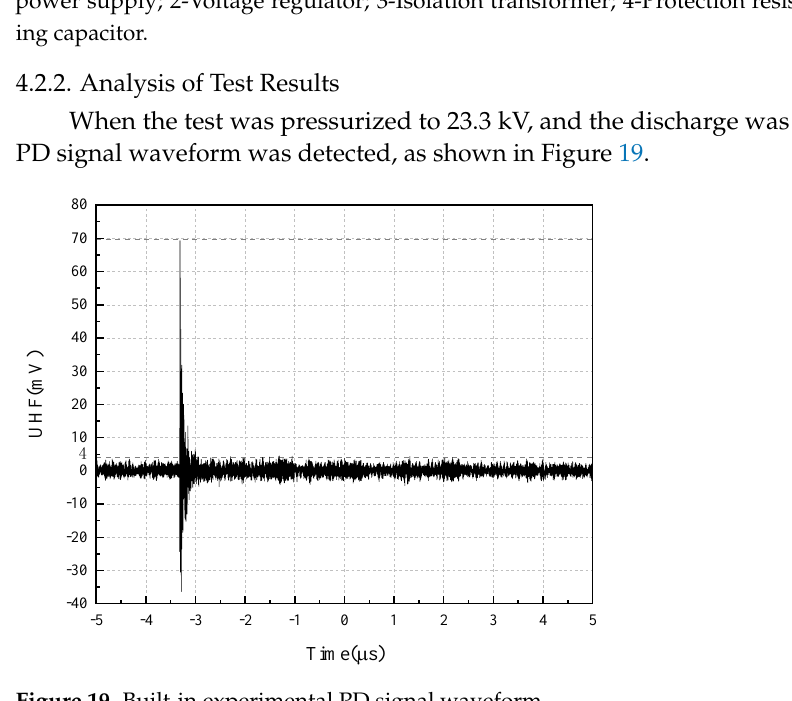
Figure 18. Flexible antenna built into the actual 220 kV GIS test circuit diagram: 1-High voltage power supply; 2-Voltage regulator; 3-Isolation transformer; 4-Protection resistor; 5-Voltage divid- ing capacitor.